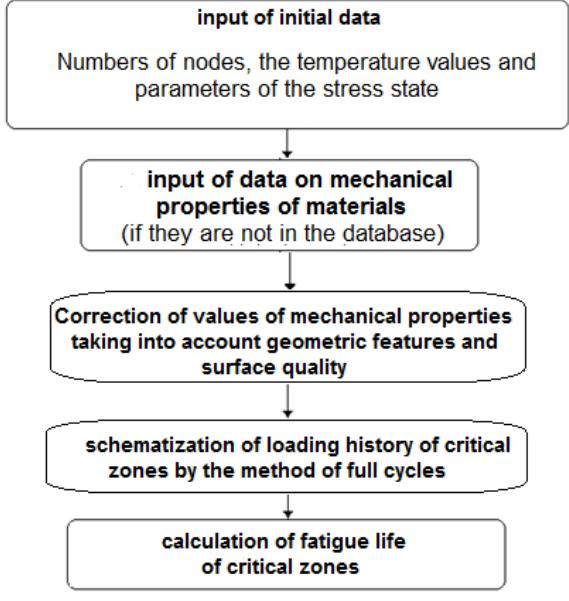
Figure 8: The block diagram of the calculation algorithm